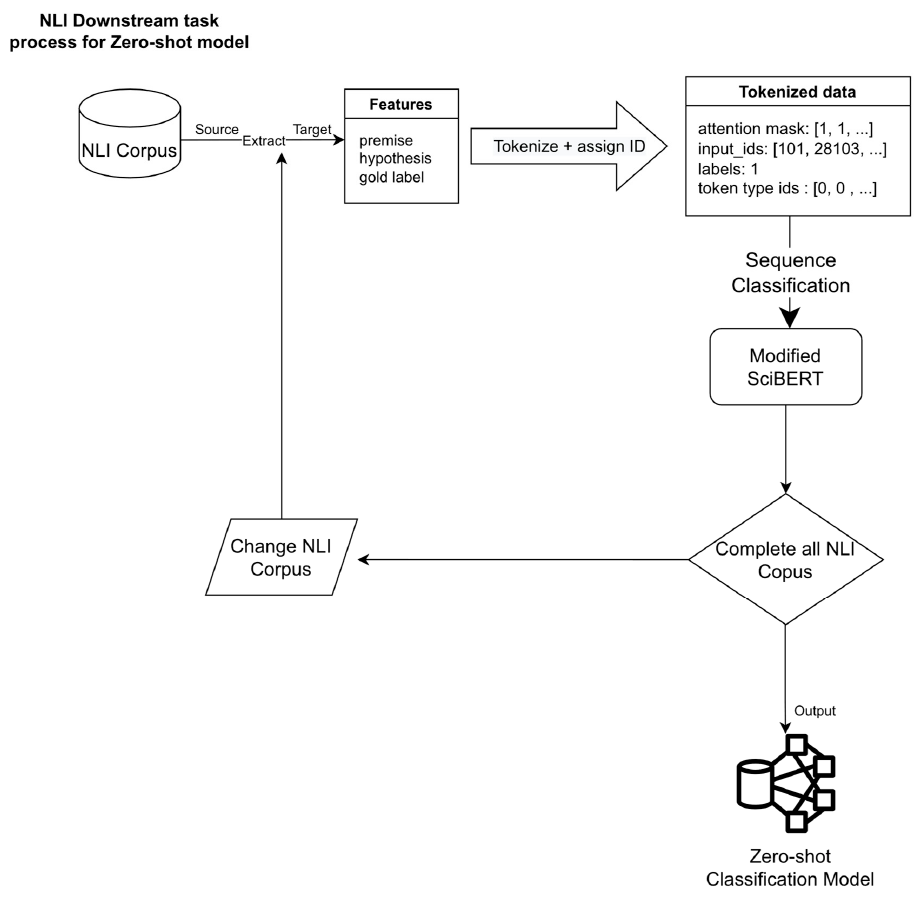
Figure 3. The detailed process for making zero-shot classification model.